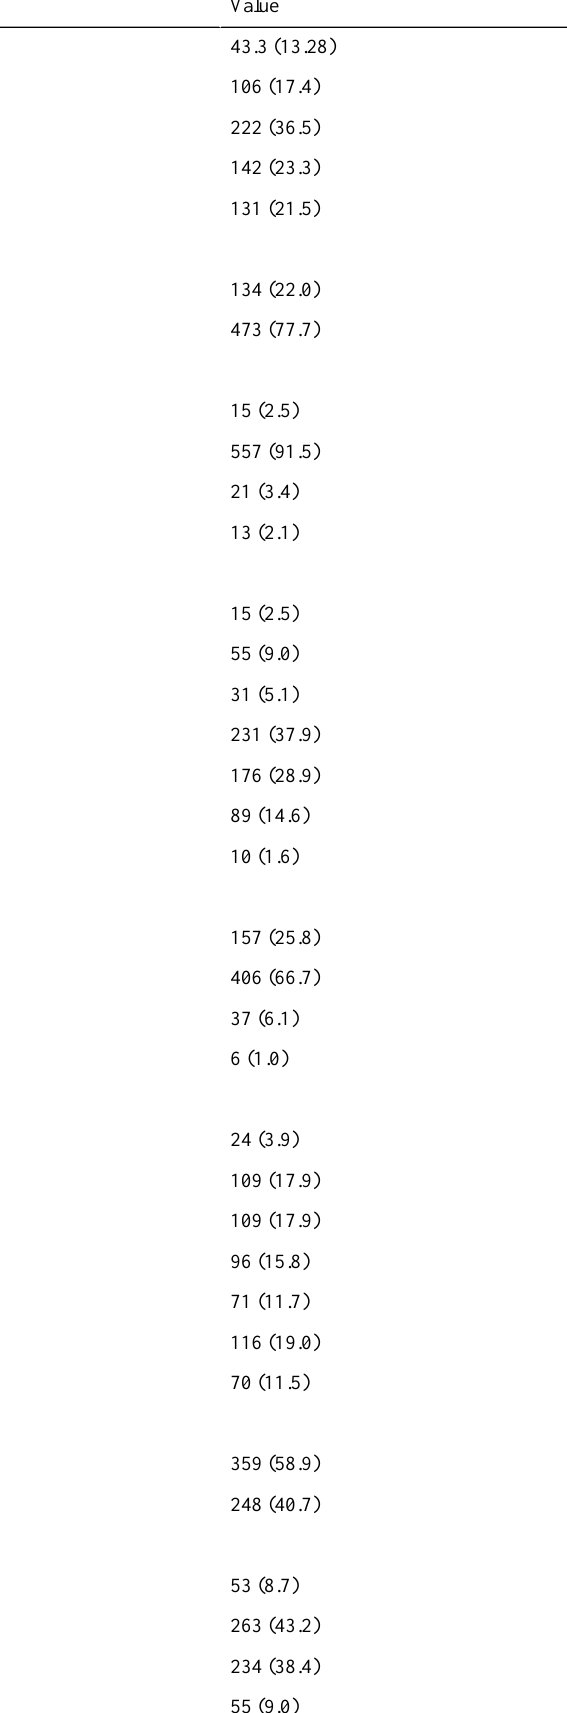
Table 1. Demographics and background of the study participants